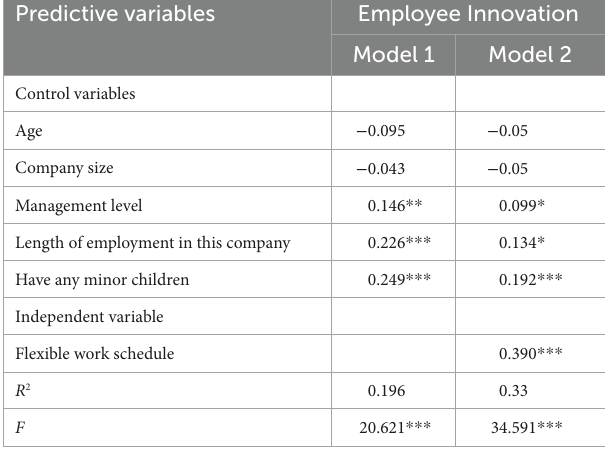
TABLE 4 Results of main effects.